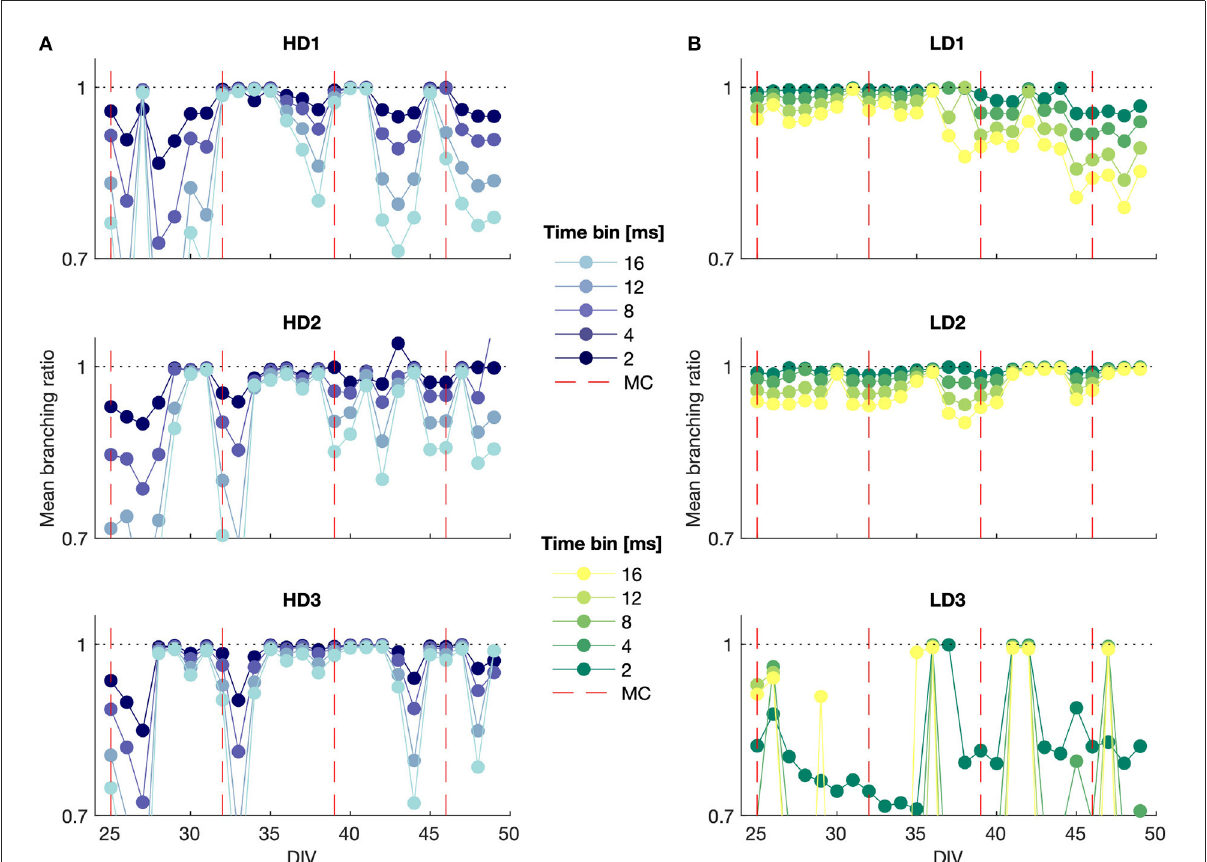
FIGURE5 MR estimate of the branching ratio calculated for different time bin sizes plotted against DIV for (A) high- and (B) low-density networks. MC, media